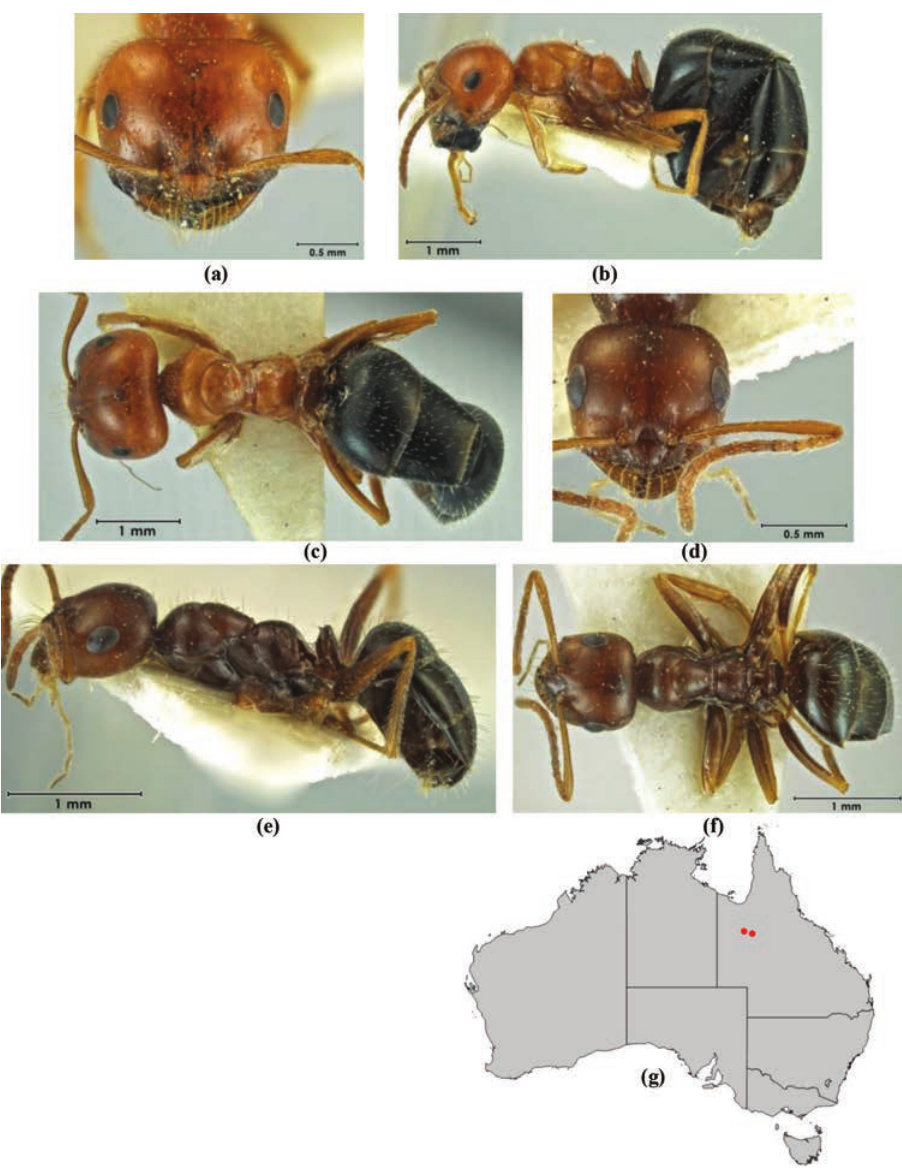
Figure 57. Melophorus gilliatensis sp. n.: major worker (ANIC32-066645–top ant) paratype frons ( a ), profile ( b ) and dorsum ( c ); minor worker holotype (ANIC32-066645–middle ant) frons ( d ), profile ( e ) and dorsum ( f ); distribution map for the species ( g